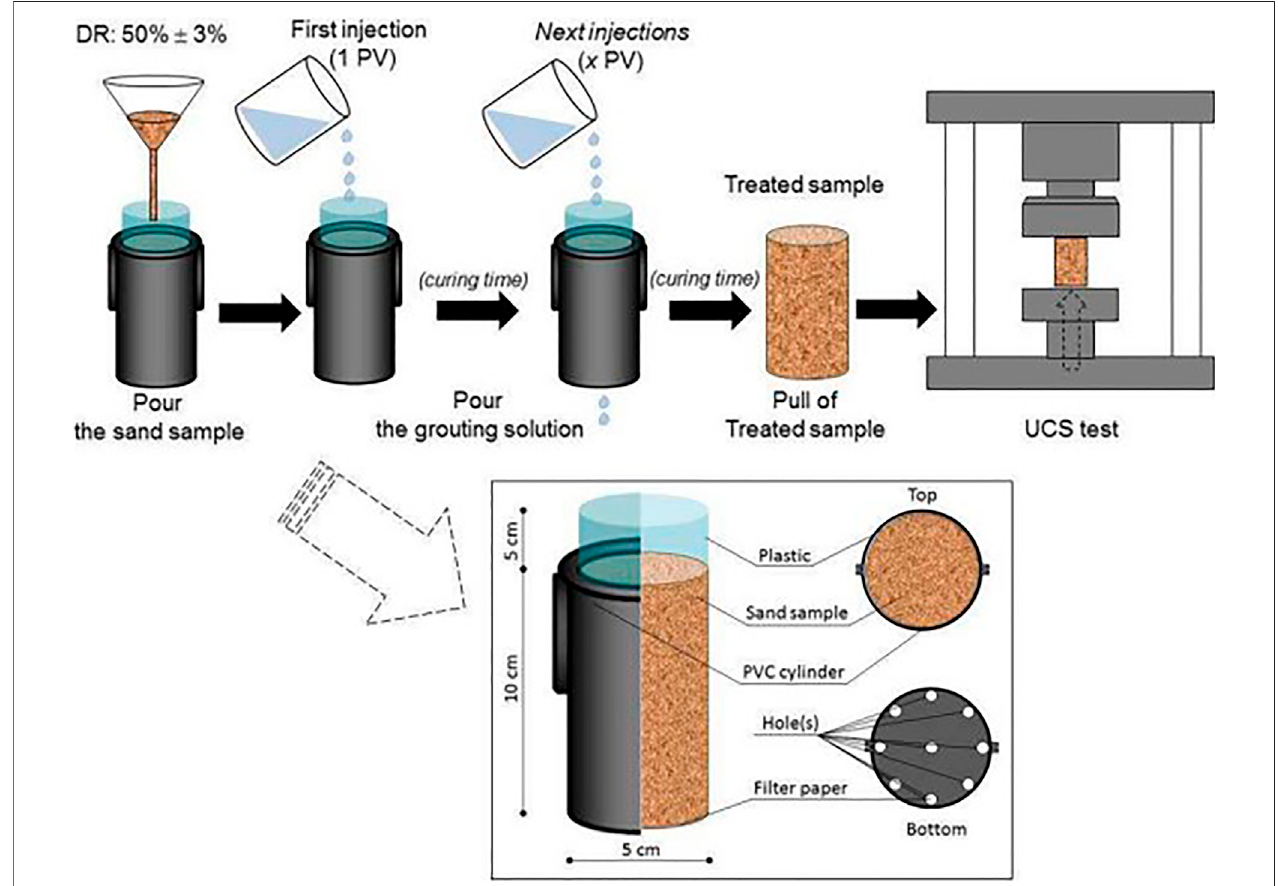
FIGURE 2 | Schematic diagram of treatment and the UCS test (Putra et al., 2017a).